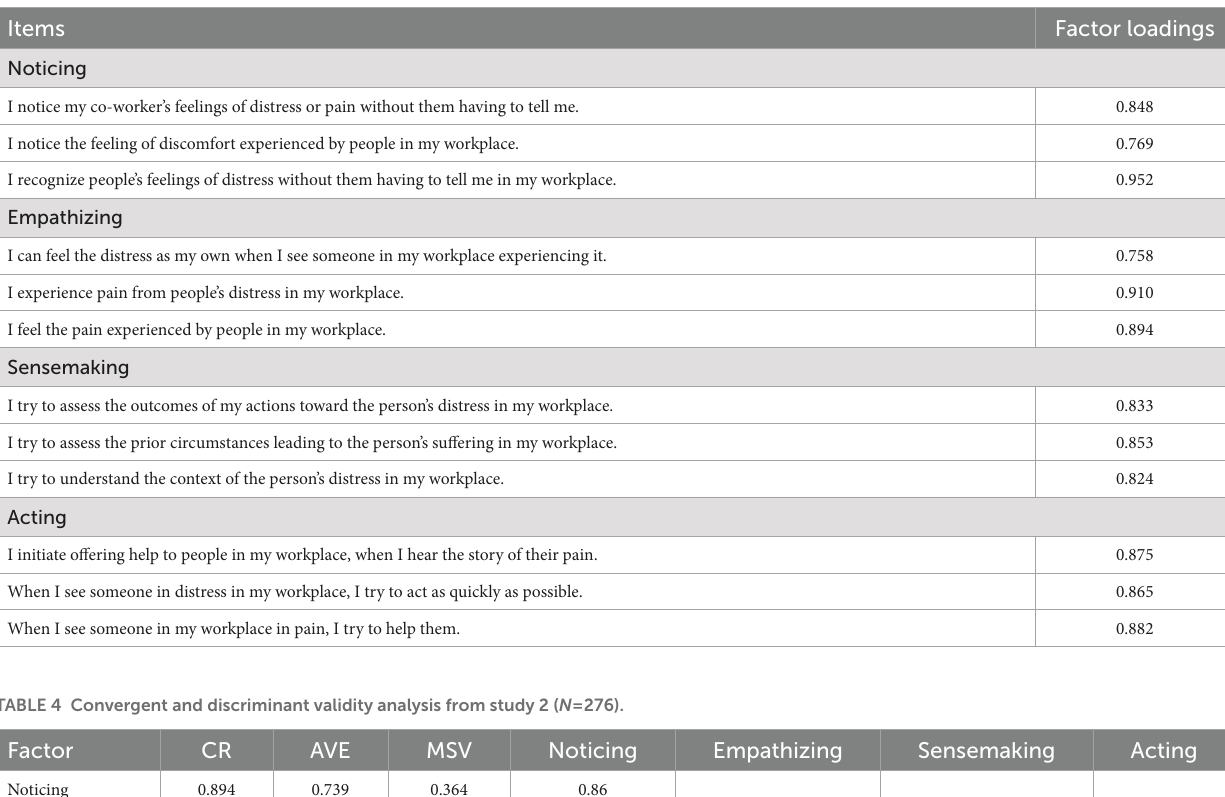
TABLE 3 Factors Loadings of confirmatory factor analysis for study 3 ( N =